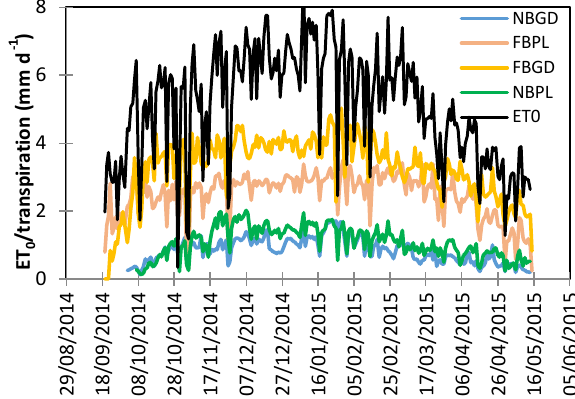
Figure 2. Water use of the young and mature apple trees and the reference